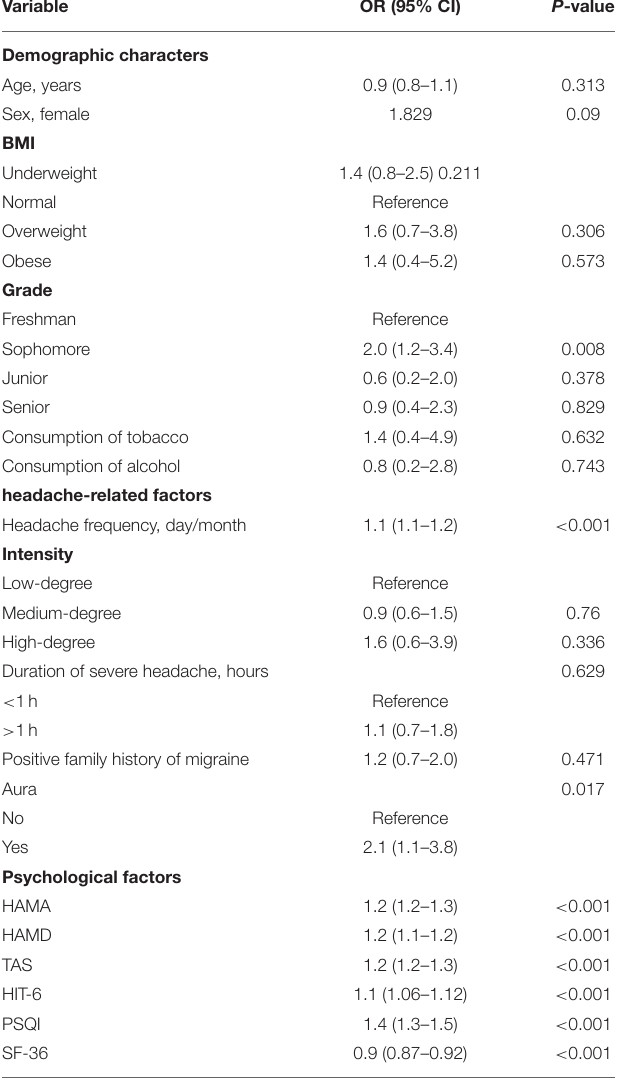
TABLE 2 | Factors associated with suicidal ideation in students with migraine using univariable logistic regression analyses.